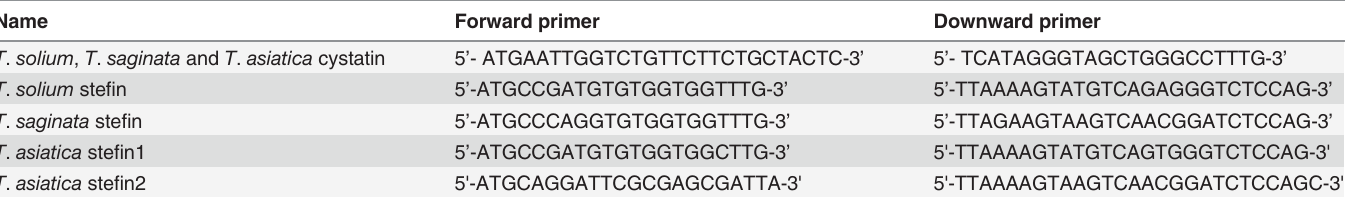
Table 1. Primers used for amplifying cystatin superfamily of T . solium , T . saginata and T . asiatica